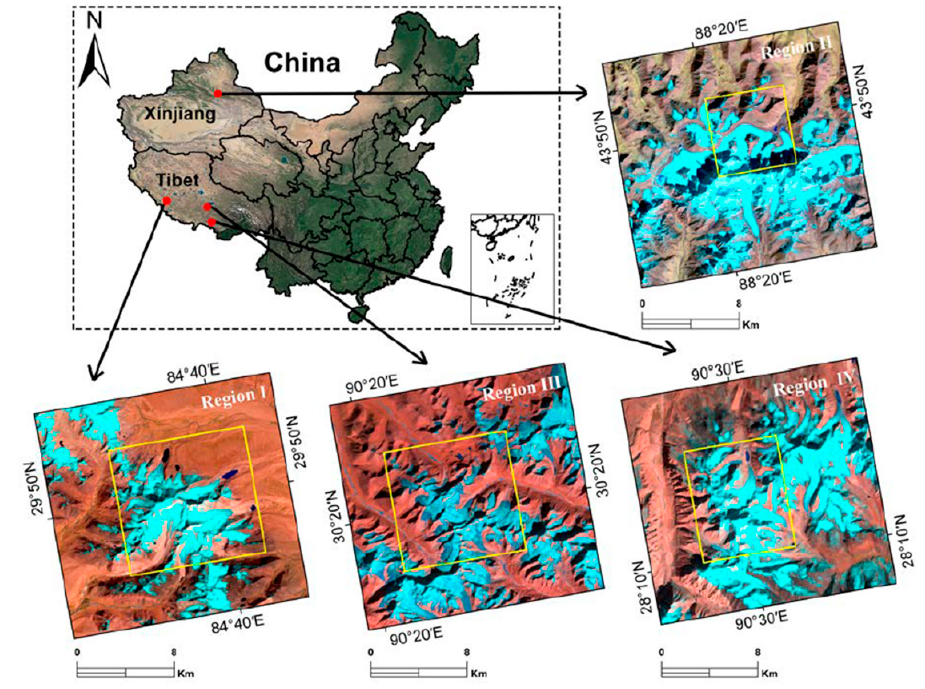
Figure 1. Locations of the four study regions.